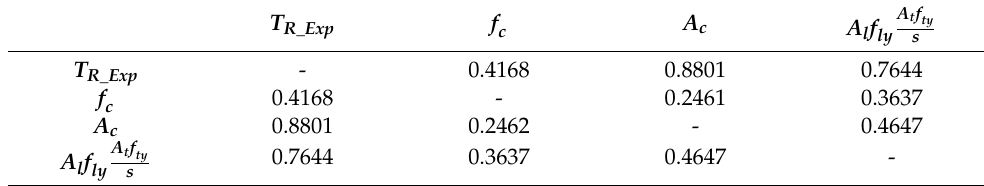
Table 1. Pearson correlation